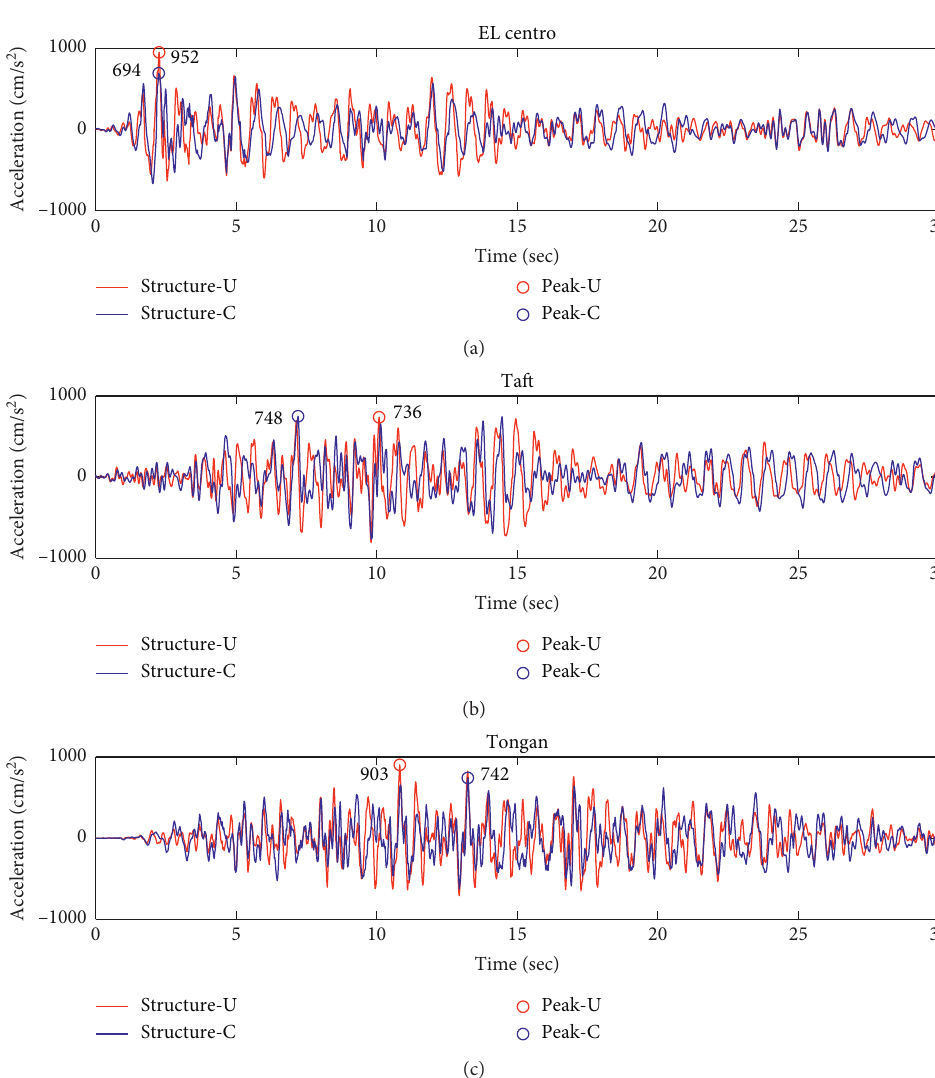
Figure 15: Time–history response of